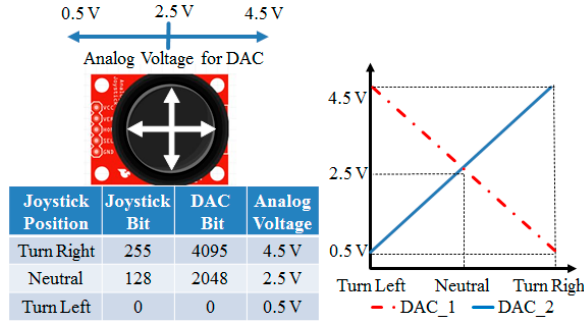
Figure 8. The control configuration of the remote controller.